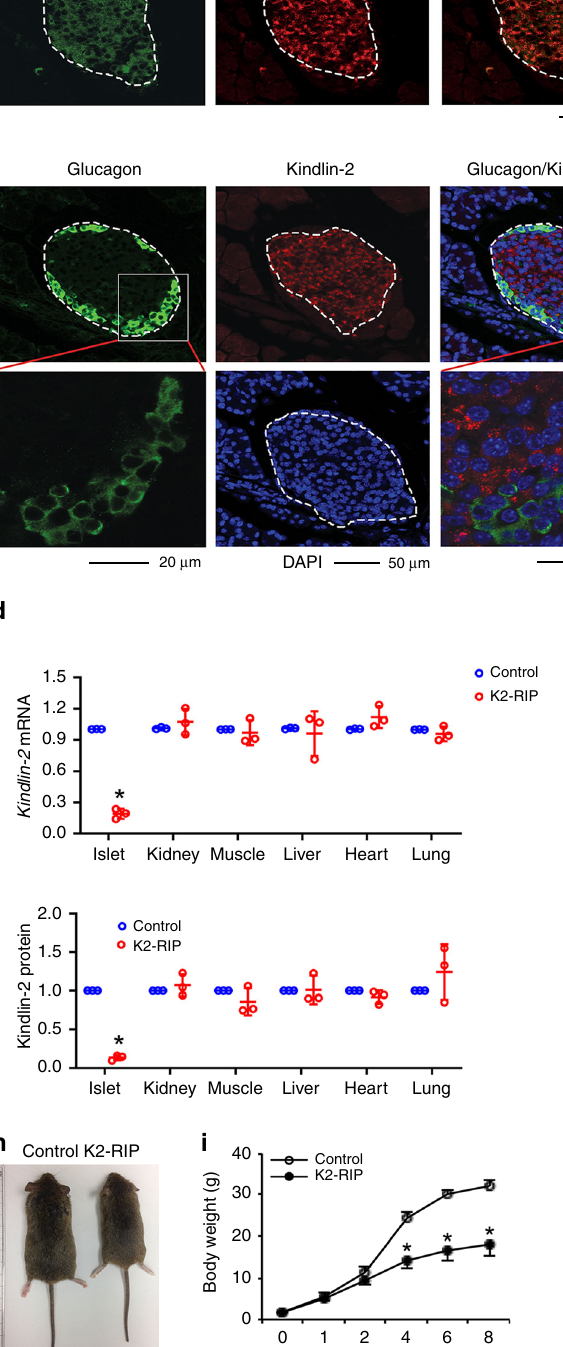
Results revealed that the blood glucose levels were signi fi cantly increased in 2- and 4-month-old male K2-RIP mice compared with sex- and age-matched control groups at all time points (Fig. 2b and Supplementary Fig. 1b). The littermates generated from breeding, including the wild-type (WT) mice that contain no Cre or fl oxed Kindlin-2 genes, Kindlin-2 fl ox heterozygotes that harbor RIP-Cre (i.e., RIP-Cre; Kindlin-2 fl / + ), Cre-negative fl oxed Kindlin-2 mice (i.e., Kindlin-2 fl / fl ) or Cre transgenic